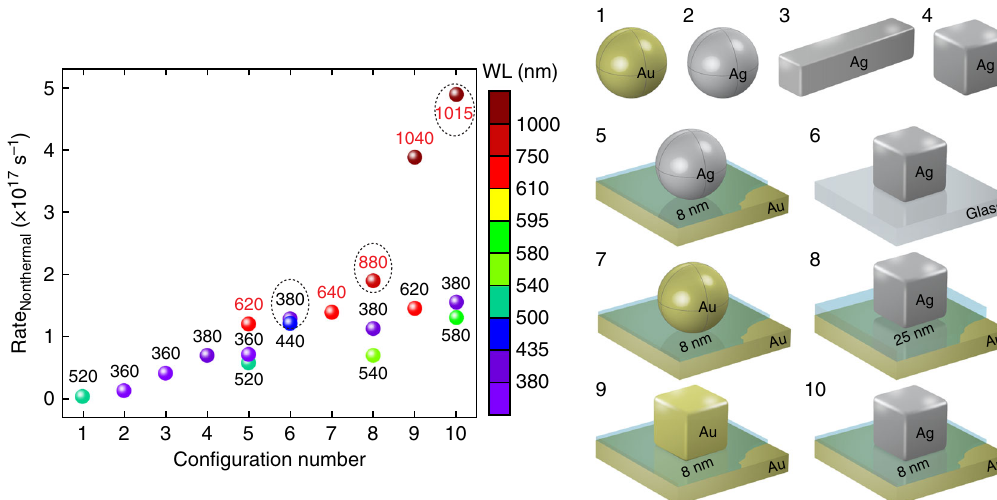
Fig. 5 Geometry dependence of nonthermal hot electron generation. Nonthermal carrier generation rates for the ten displayed nanoparticle con fi gurations are plotted with their corresponding plasmon resonance wavelengths, which are labeled and color-coded for clarity. Red text corresponds to gap plasmon resonances. Geometries employing Ag exhibit higher rates than Au owing to lower damping and a longer momentum relaxation time, and generation through gap excitation is shown to be much more ef fi cient than bare nanoparticle resonances. In all cases the nanoparticle volume was fi xed at (150 nm) 3 , corresponding to a diameter of 185 nm for the nanospheres and a 340 nm length (100 nm edge) for the nanorod. In the nanopatch geometries (5, 7 – 10) an Al 2 O 3 spacer was employed with the corresponding thickness